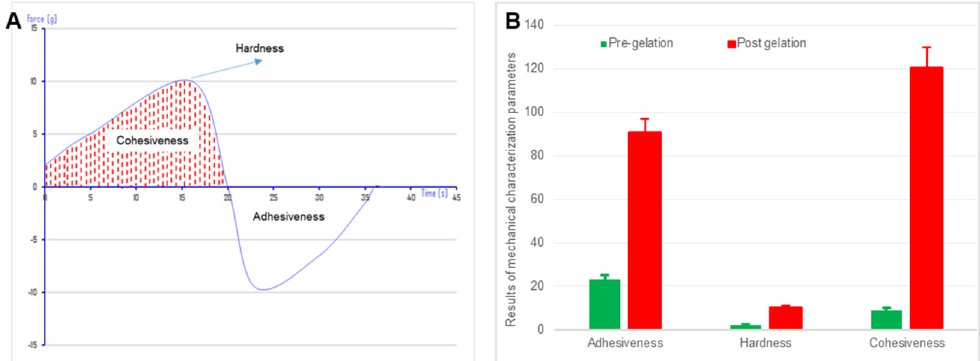
Figure 5. ( A ). Representative graph of force versus time relationship of naringin loaded in situ nanoemulgel post-gelation showing hardness (g), cohesiveness (g.sec, Area under curve; Dotted) and adhesiveness (g.sec, Area under curve; Plain) and ( B ). Bar graph representing comparison of various mechanical characteristics of naringin loaded in situ nanoemulgel, pre and post gelation namely adhesiveness (g.sec), hardness (g) and cohesiveness (g.sec). Data represents mean of 3 independent determination. Error bars indicate SD.